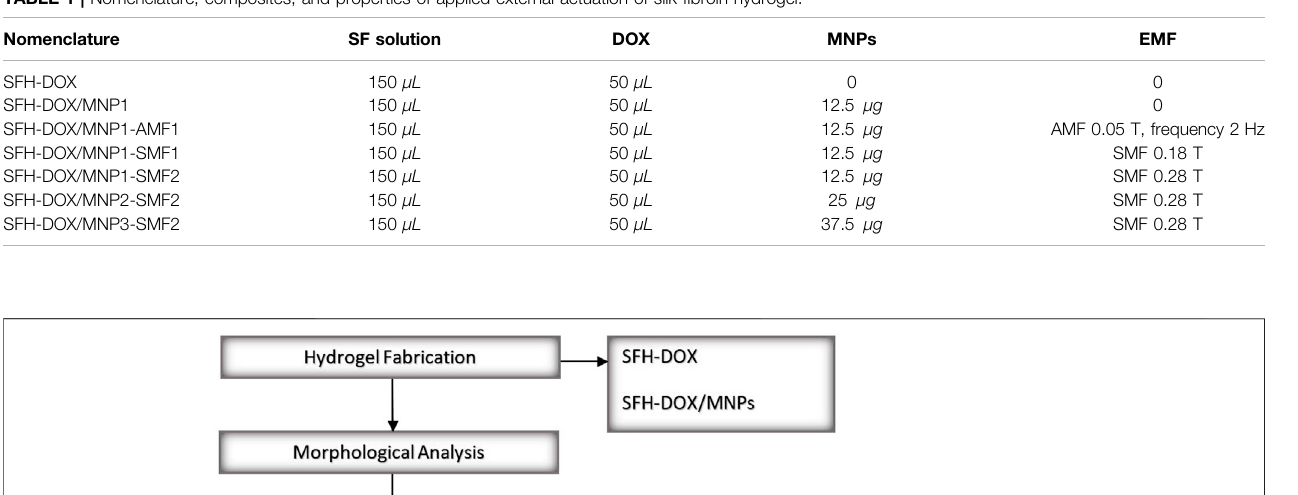
TABLE 1 | Nomenclature, composites, and properties of applied external actuation of silk fi broin hydrogel.